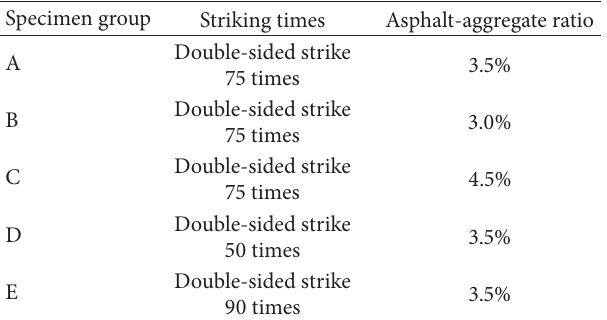
Table 2: Modeling process of